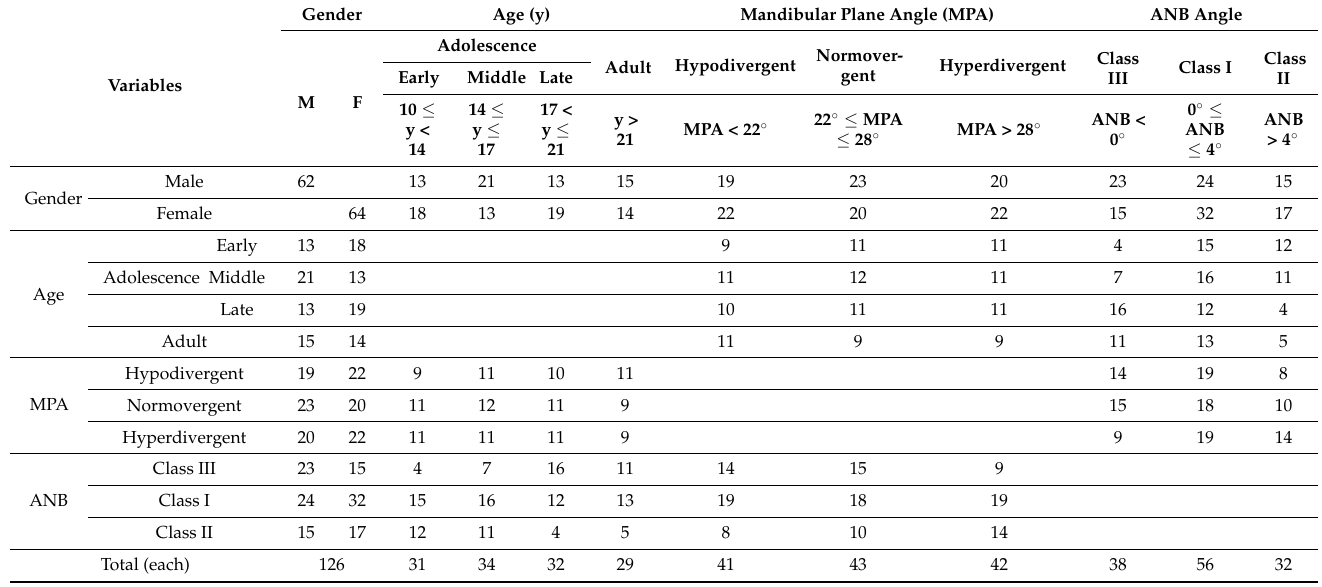
Table 1. Sample distribution